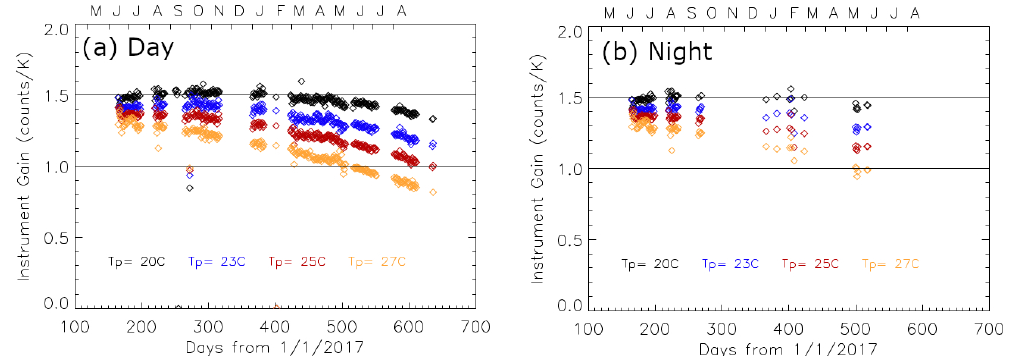
Figure 5. Time series of daily gain for (a) daytime and (b) nighttime when the Tp 4 value equals to 20 ◦ C (black), 23 ◦ C (blue), 25 ◦ C (red) and 27 ◦ C (orange). The gain declines consistently with increasing instrument temperature.